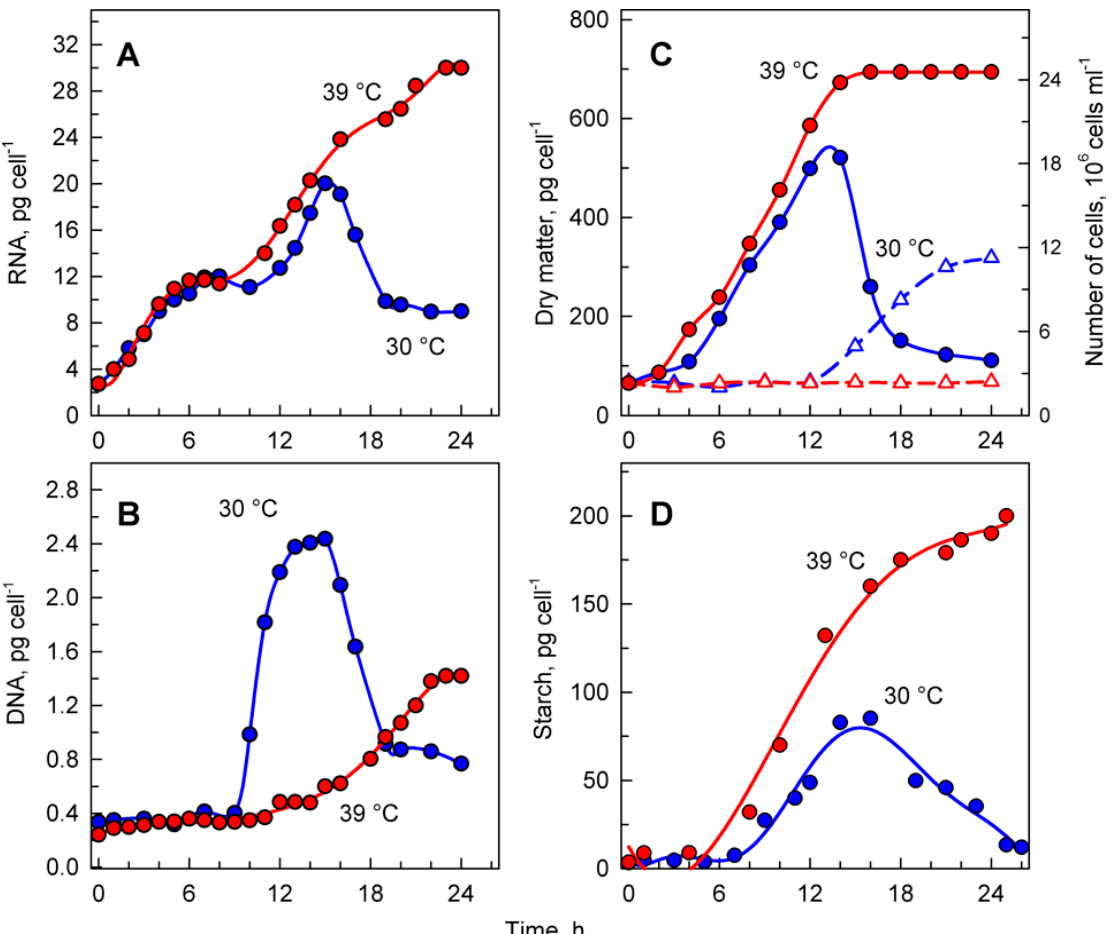
Figure 4. The course of RNA synthesis ( A ), DNA replications ( B ), changes in the number of cells and concentration of dry matter ( C ), and total starch ( D) in the synchronized culture of Chlamydomonas reinhardtii grown under continuous illumination of incident light intensity 500 µmol m − 2 s -1 at 30 °C (blue lines and symbols) or 39 °C (red lines and symbols).